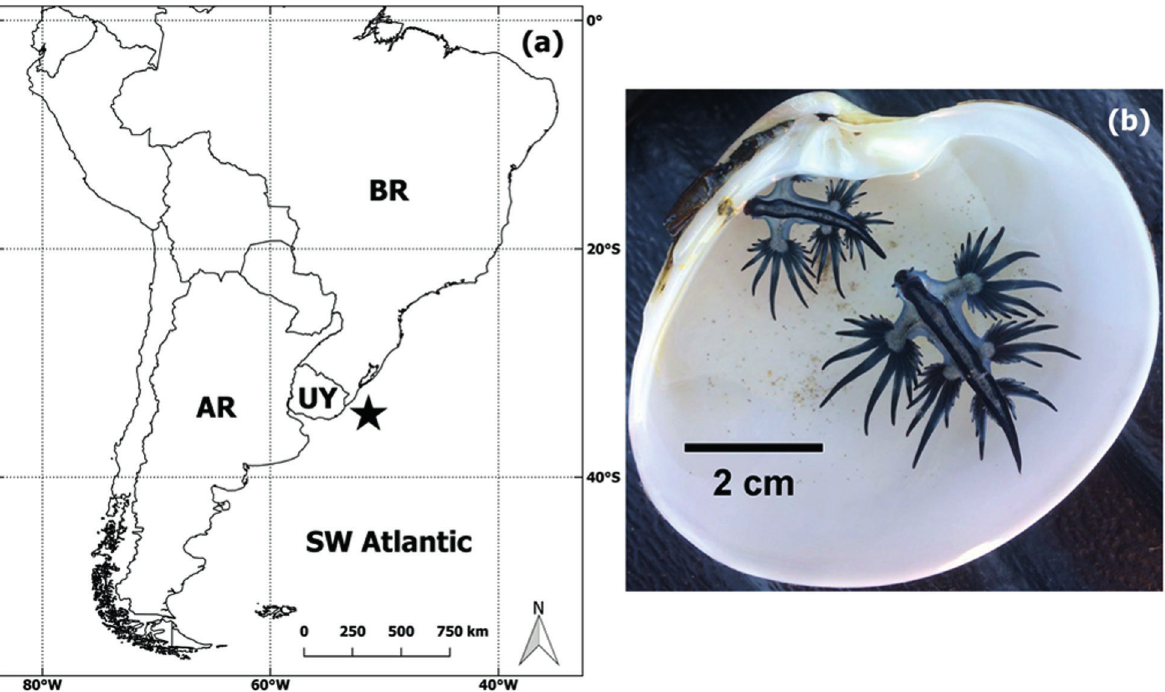
Figure 1 - Brazilian (BR), Uruguayan (UY) and Argentinean (AR) shores, evidencing the area in which Glaucus atlanticus was reported during the summers of 2011 and 2017 ( a ). During the 2017’ strandings, G. atlanticus ( b ) and several cnidarians were found scattered within the upper intertidal at Cassino Beach (32.174º S; 52.134º